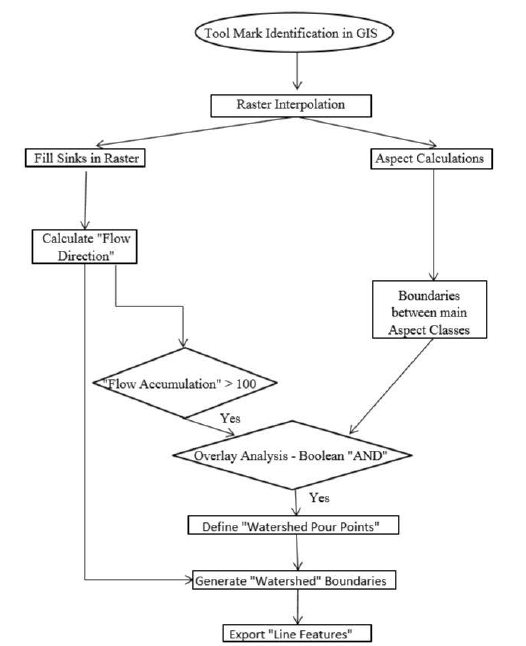
Figure 4. The work steps of the automatic tool mark recognition in GIS environment